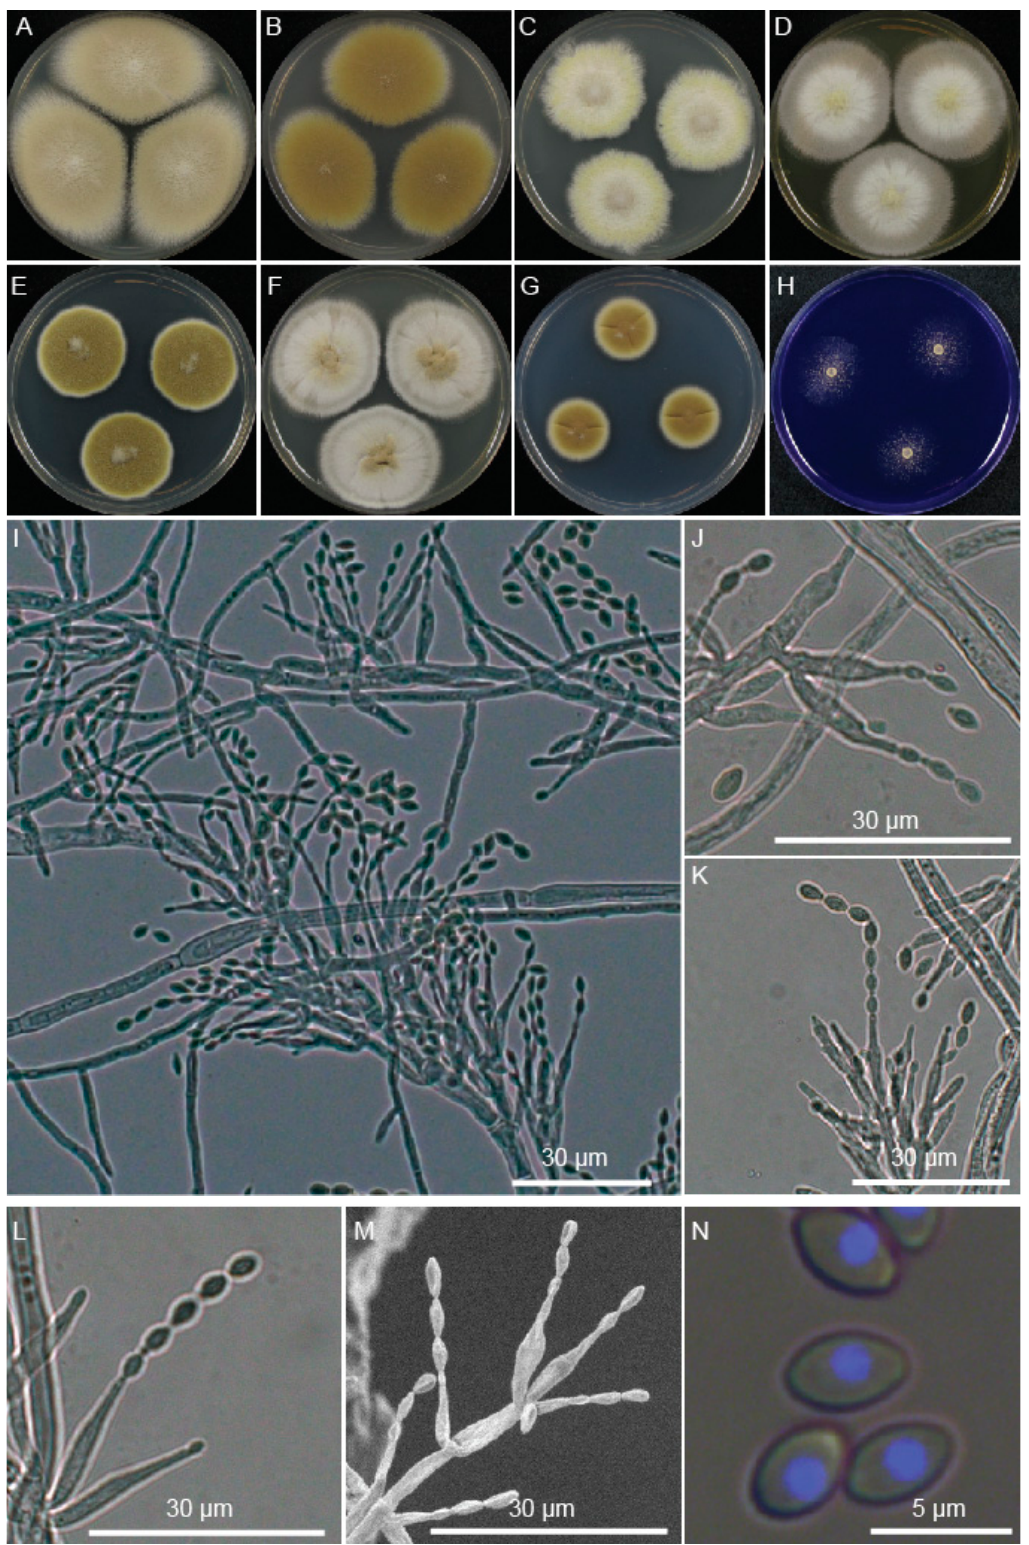
Figure 5. Morphology of P. paravariotii FRR 5287. Five-day-old colonies grown at 30 °C on 90 mm plates of ( A ) MEA, ( B ) V8, ( C ) SD-ura, ( D ) YES, ( E ) PDA, ( F ) CYA, ( G ) minimal, and ( H ) CREA. ( I – M ) Conidiophores. ( N ) Conidia overlayed with histone-H2B CFP fluorescence.